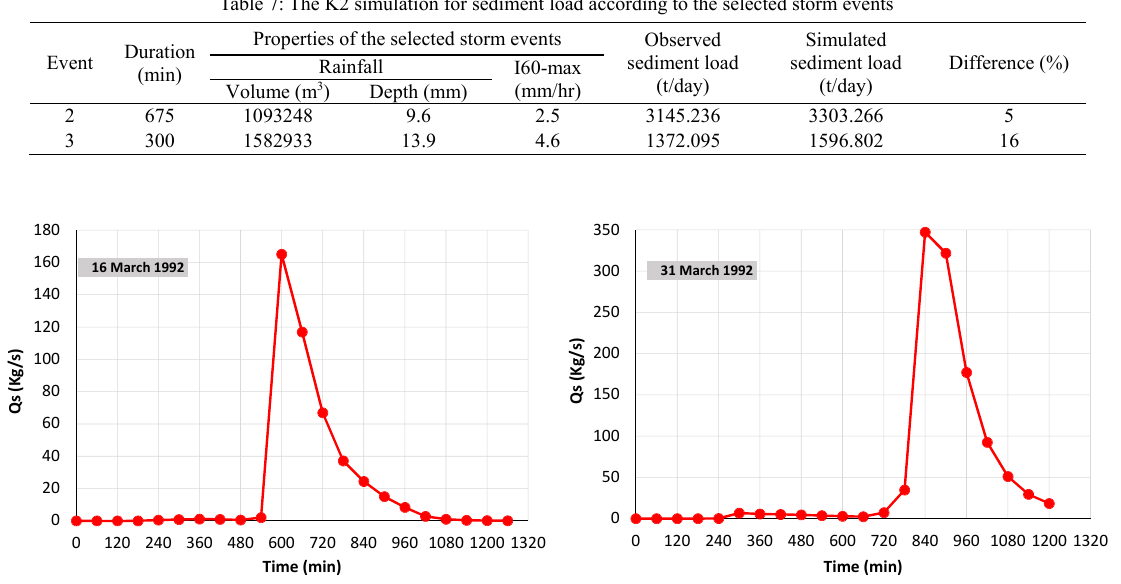
Fig. 7: Simulated sedigraphs, based on the selected storm events